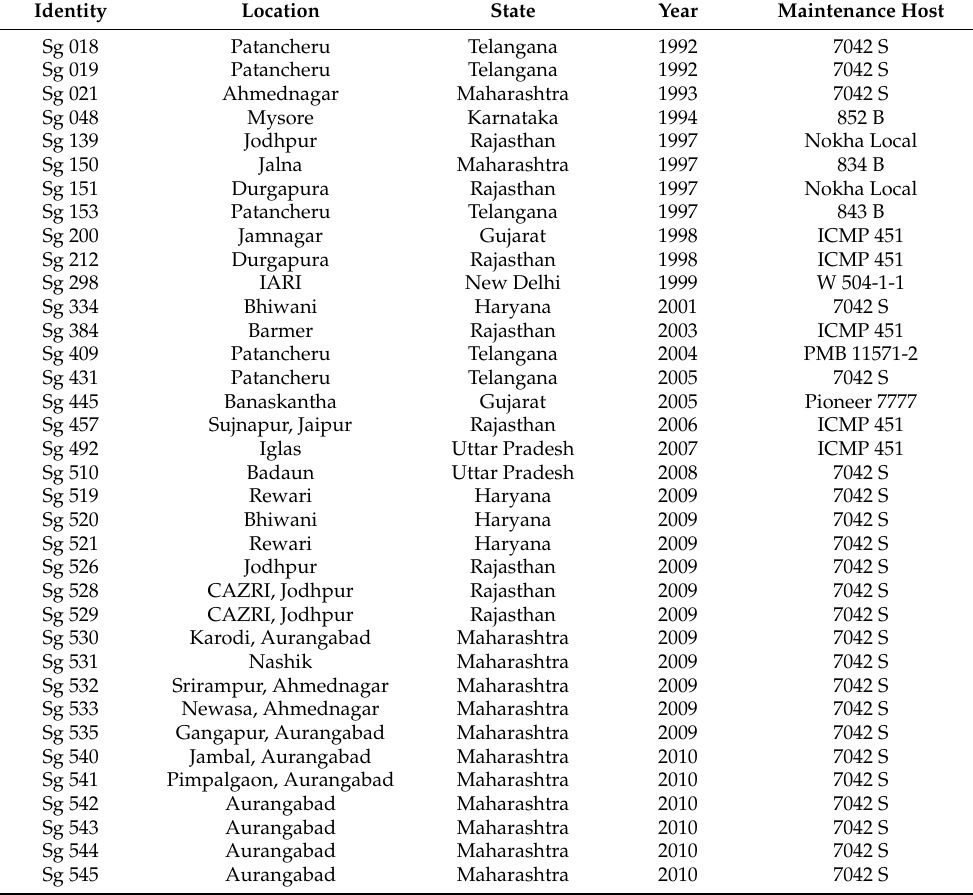
Table 1. Sources of Sclerospora graminicola isolates collected from different pearl millet growing states of